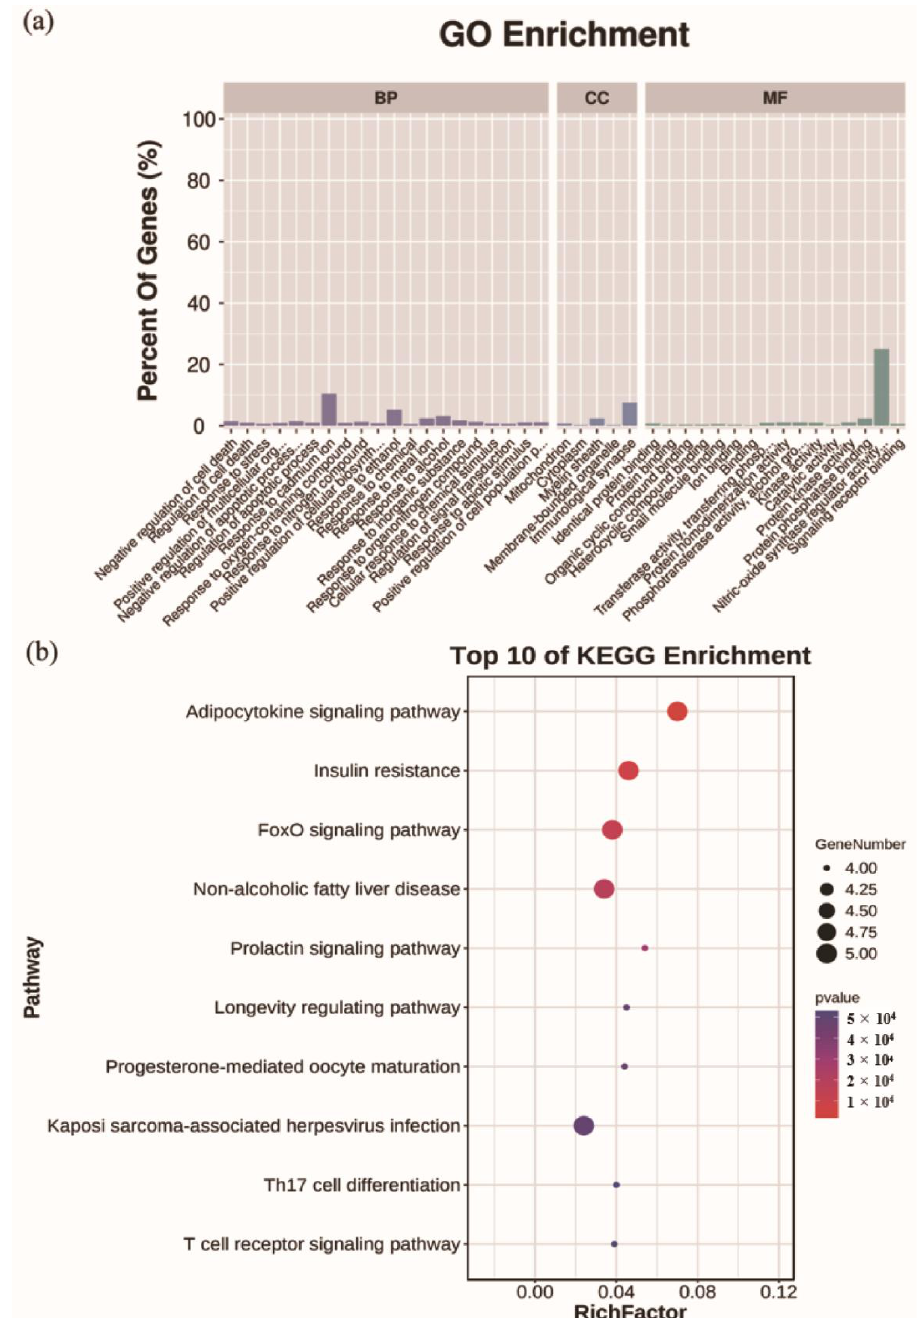
Figure 6. GO terms and KEGG pathways enrichment analysis of the overlapped targets. ( a ) Gene Ontology (GO) terms for biological processes (BP), cellular components (CC), and molecular function (MF), ( b ) KEGG pathways.